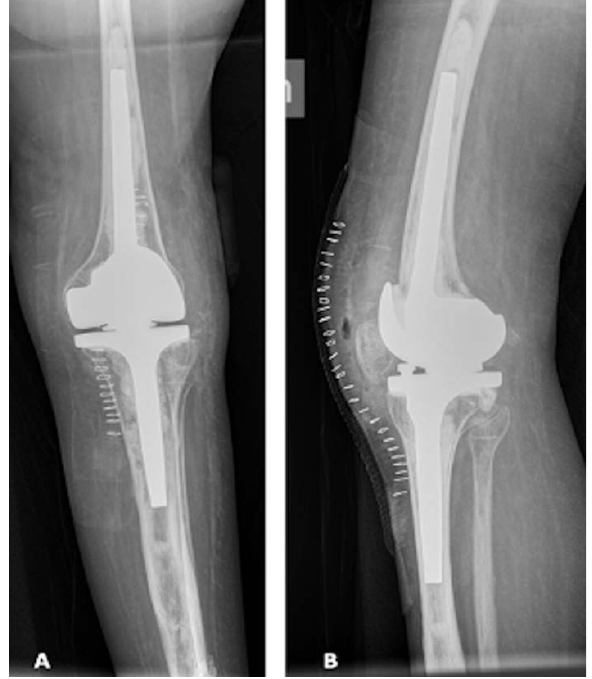
Figure 5. Post-operative X-ray. ( A ) Antero-posterior view; ( B ) lateral view. 3.4. Application of 3D-Printed Models in Pre-Operative Planning of Revision Total Knee